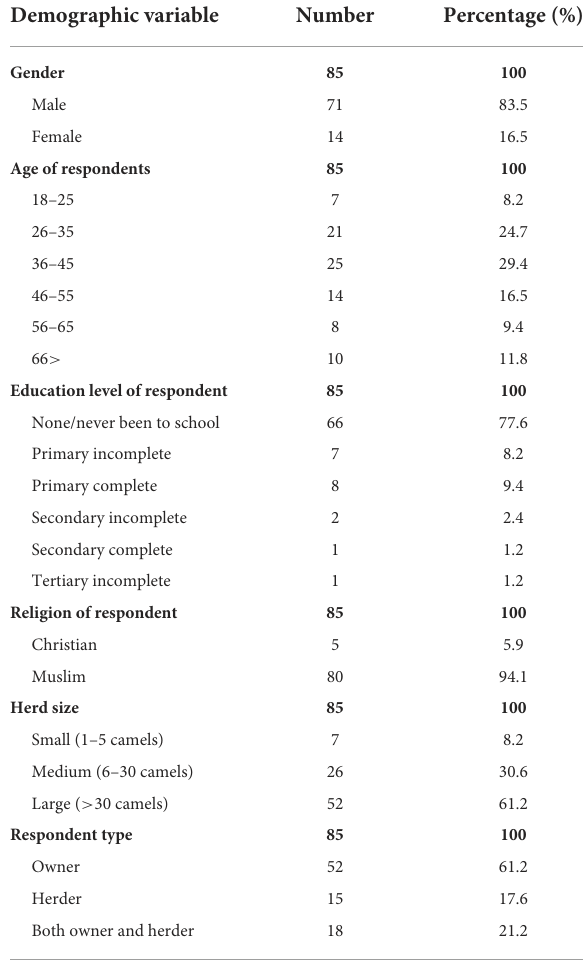
TABLE 1 Demographic variables of the